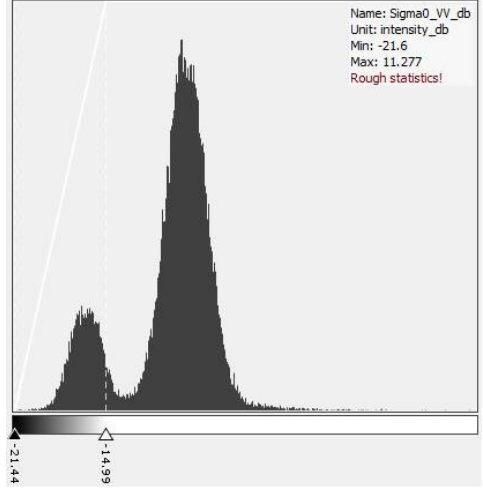
Figure 3. Procedure of selecting threshold on VV Polarized image